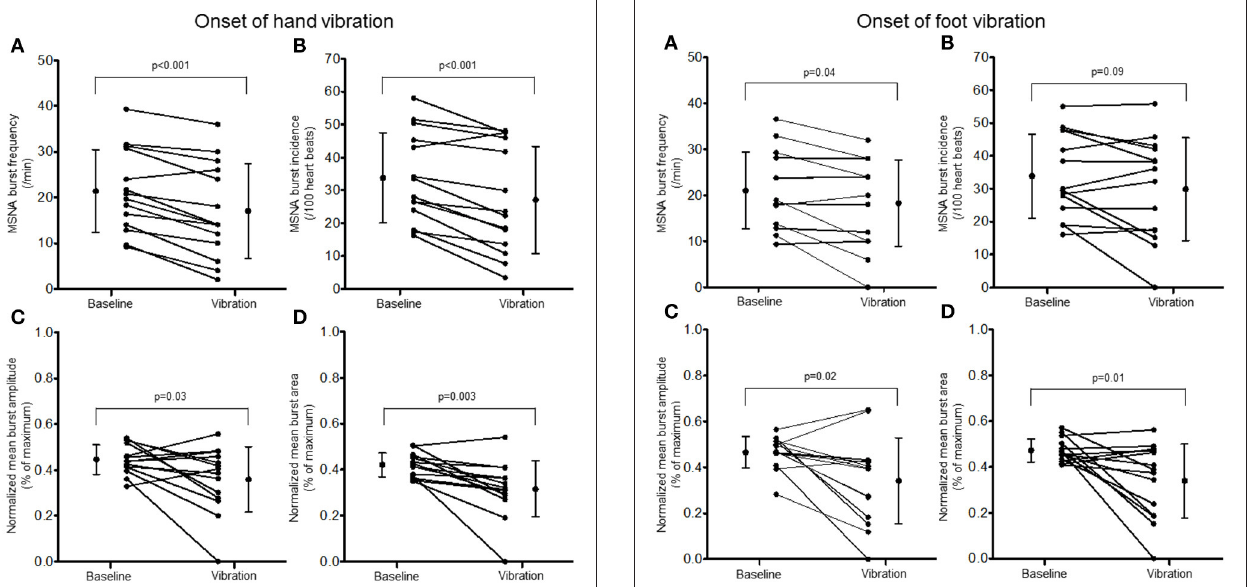
p = 0.085; Figure 6 ). Reductions in MSNA burst frequency were found in 9/14 participants during onset of foot vibration.